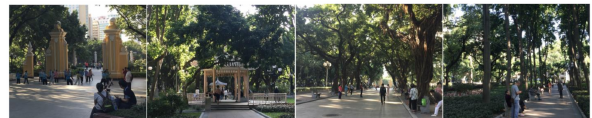
Figure A2. Recreation spaces in Renmin Park.